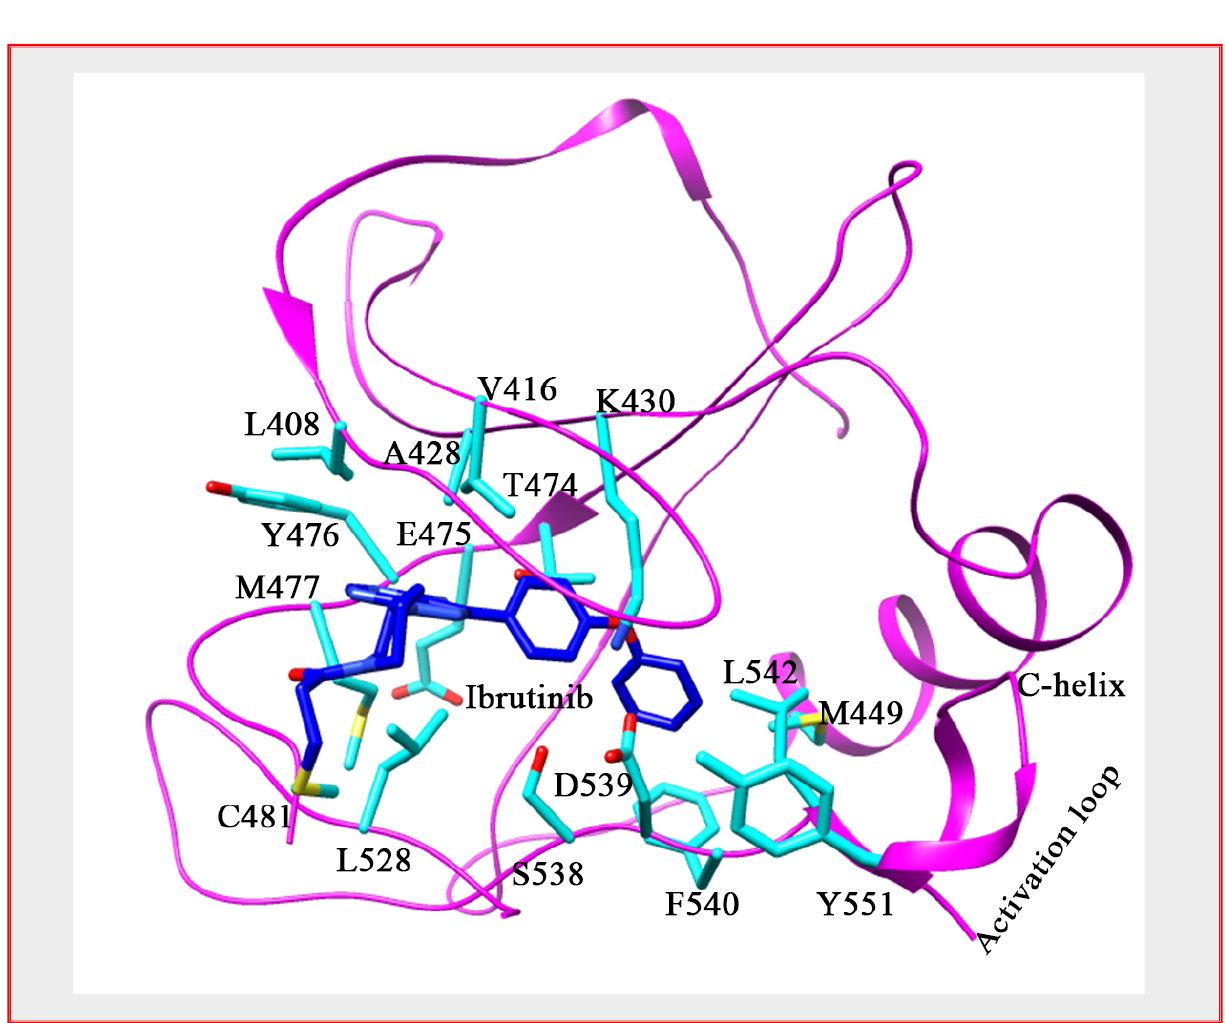
Figure 4. BTK’s interaction with ibrutinib. The crystal structure of BTK bound with inhibitor ibrutinib showing the interaction with protein (PDB: 5P9J). Protein colored in magenta, side chain in cyan and Ibrutinib in blue, ball and